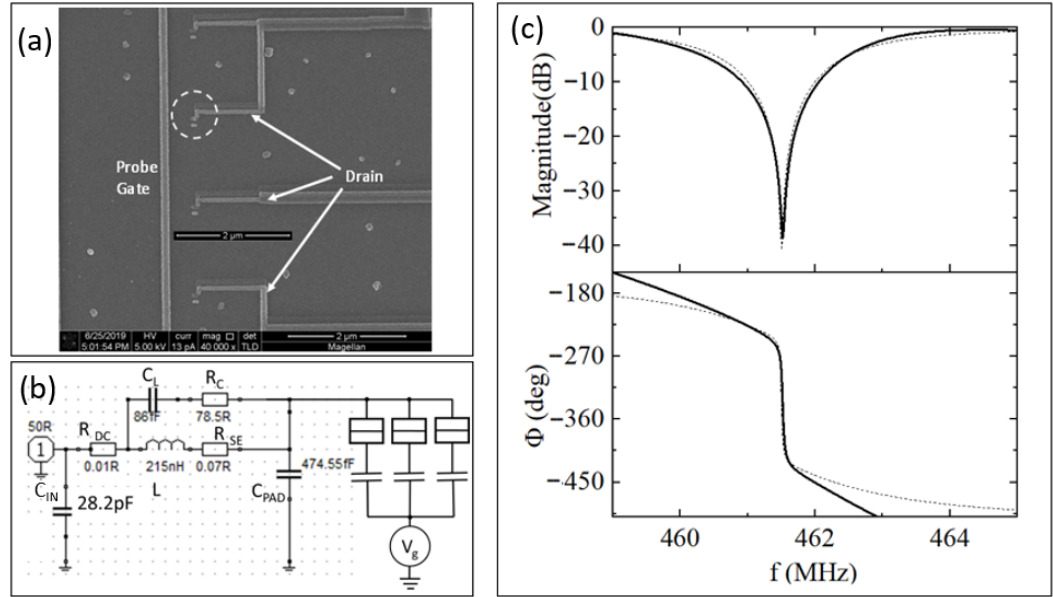
Figure 10. ( a ) High resolution SEM image of the 3 SEBA (only 3 out of 4 SEBs are operational). The three lines leading to the right are drains that are bonded in parallel to the MN. The vertical line situated about 0.5 µm away from the islands is the probing gate. The tuning gate is situated much farther (about 10 µm) below the entire array (not shown). A fabrication defect for one SEB is delineated by a dashed white line. The data for the 3 SEBA presented below are obtained from this very device. ( b ) Model of the MN used in simulations. The values of C L = 86 fF and L = 215 nH are from the Coilcraft datasheet. The values of R DC and R SE are both adjusted based on measured resistivity reduction at low temperature; C PAD is calculated by fitting the resonant frequency to the experimental data, and the value of R C is adjusted to obtain the observable depth in the magnitude response. ( c ) Experimentally obtained (solid lines) and simulated (dashed lines) frequency response of the reflectometry setup using the MN in ( b ), T = 11.5 K.